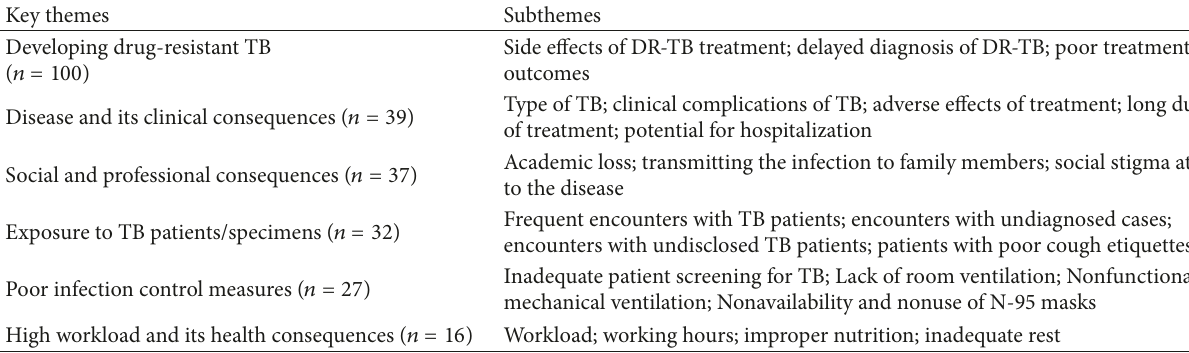
Table 3: TB risk perceptions among resident doctors, key themes and